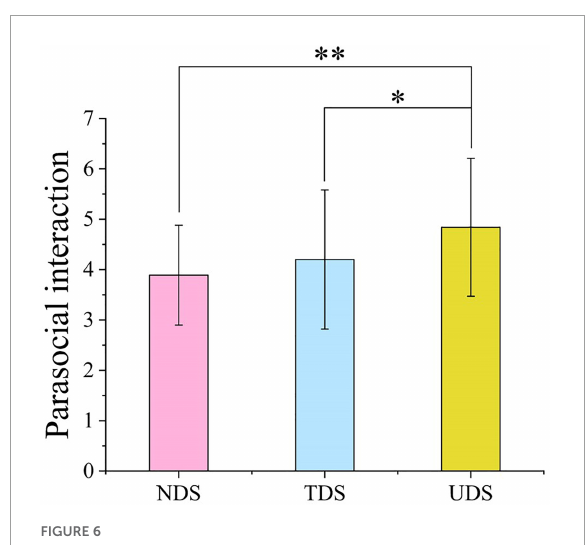
FIGURE6 Differences in parasocial interaction across the experimental conditions. ∗ p < 0.05, ∗∗ p <